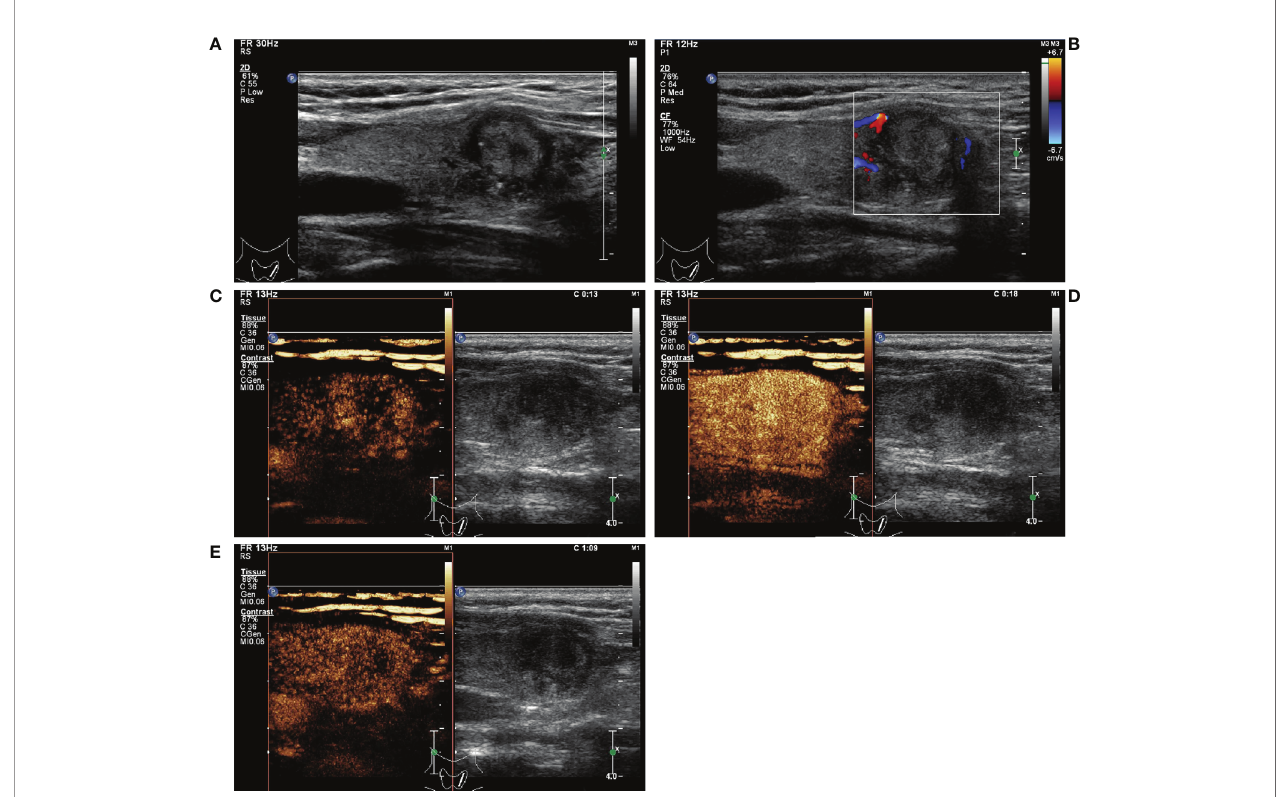
FIGURE 4 | A follicular variant of papillary thyroid carcinomas in a 53-year-old woman. (A) Greyscale ultrasound showed that there was a solid isoechoic nodule in the left lobe of the thyroid, with irregular hypoechoic halo, irregular margin, wider-than-tall shape, and punctate echogenic foci. The nodule was ACR TI-RADS category 5. (B) Color Doppler showed peripheral vascularity. (C) Contrast-enhanced ultrasound revealed the trend that contrast agent enters the nodule from the periphery to the center (centripetal enhancement) at the time of the 13th second after the injection of contrast agent. (D) Contrast-enhanced ultrasound revealed heterogenous hyper-enhancement at peak (the 18th second after the injection of contrast agent), without a regular enhanced ring. (E) Contrast-enhanced ultrasound revealed heterogenous hypo-enhancement within the nodule at the 69th second after the injection of contrast agent, which indicates earlier wash-out than the surrounding thyroid